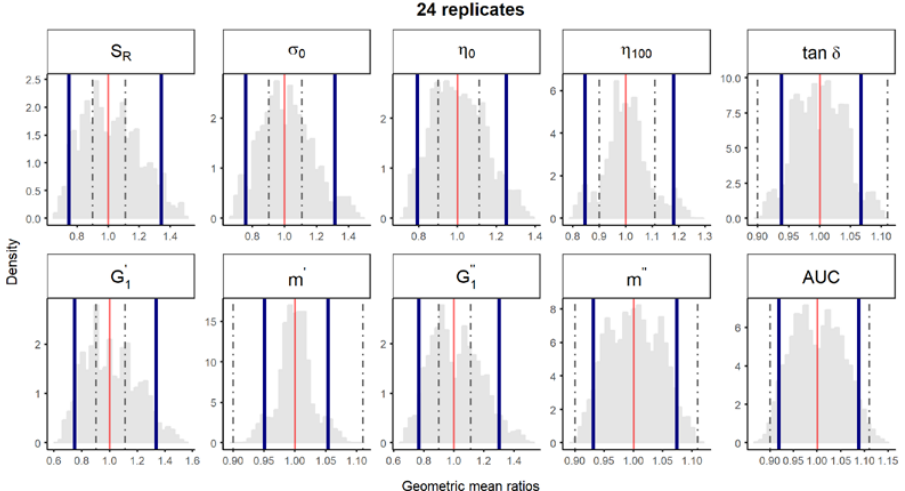
Figure S2. Bootstrap analysis of rheological parameters using 6 replicates—1 reference batch versus 1 reference batch. A total of 10,000 geometric mean ratios (light grey area) resulting from the bootstrap analysis of “1 reference batch versus 1 test batch” for each rheological parameter. Data of 10 batches and 6 replicate each were used. Median (red line) and non-parametric 90% CI (blue lines) of the probability distribution. Dashed lines represent the acceptance limits for equivalence (90%–111.11%) stated in the EMA guideline [4]. S R , relative thixotropic area ; σ 0 , yield stress; η 0 , zero-shear viscosity; η 100 , viscosity at 100 s −1 ; tan δ , loss tangent at 1 Hz; G (cid:48) , calculated elastic modulus; G (cid:48)(cid:48) , calculated viscous modulus; m' and m" are the parameters obtained when fitting G' and G'' , respectively, versus frequency; AUC , area under the weight versus surface curve (spreadability).